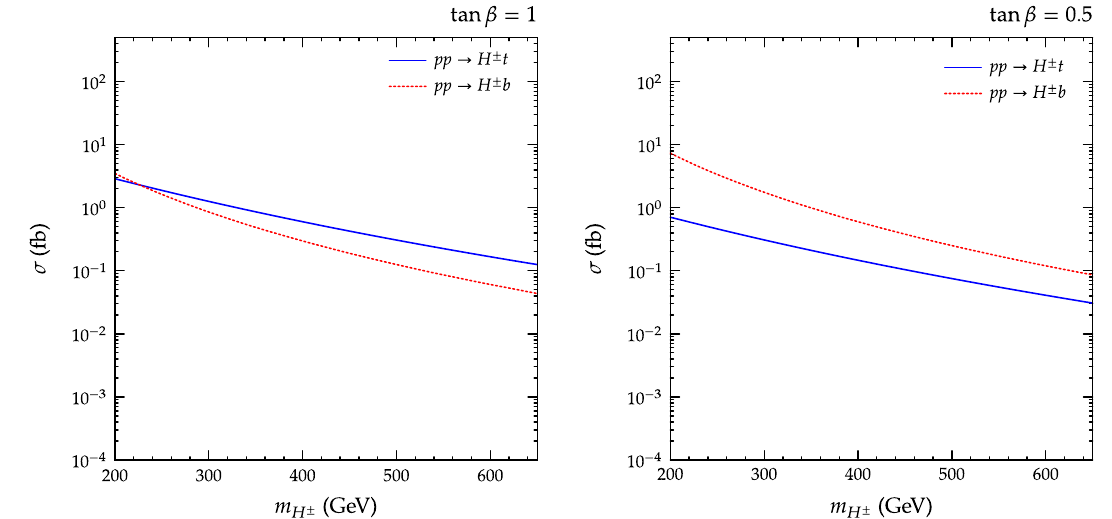
Fig. 10 Production cross sections of the heavy charged Higgs H ± at 14 TeV proton-proton collisions. We have chosen tan β = 1 (left panel) and = y SM tan β = 0 . 5 (right panel) with y u 33